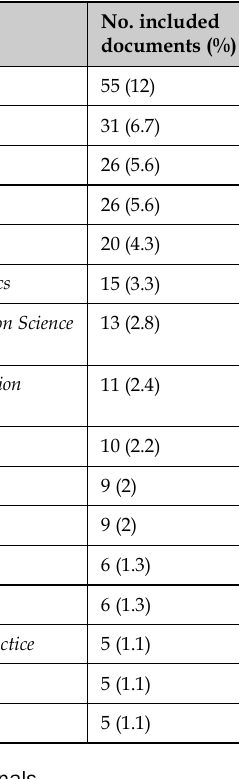
Figure 2 Number of documents and number of